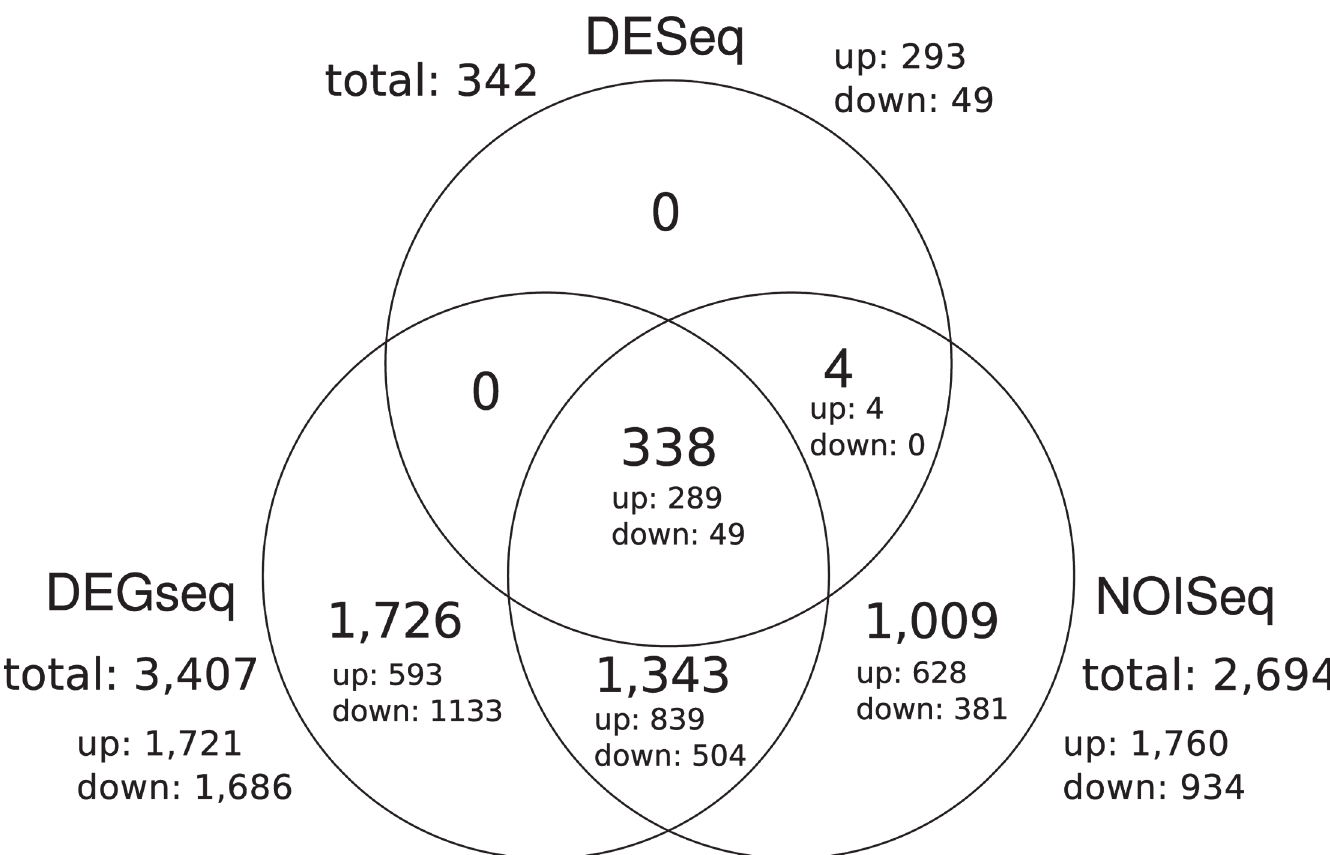
Fig 3. Venn diagram of the overlapping DE transcripts from the DEGseq, DESeq and NOISeq analyses. The amount of up- and down-regulated transcripts is given for each segment.